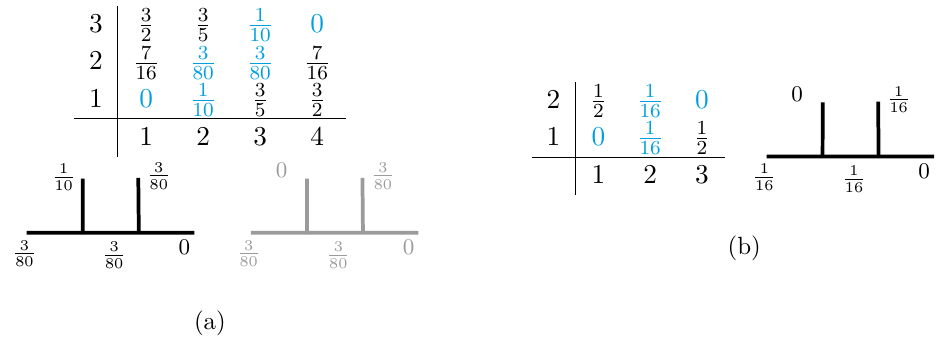
Figure 4. Here we list the first possible examples of CBs that Γ 0 (4) ∩ Γ(2) corresponds to: (a) The first CB for (+ , + , − , − ) . For reference, the one in grey is the CB from ( − , + , − , +) for this minimal model. (b) The first CB for ( − , + , − , +) .